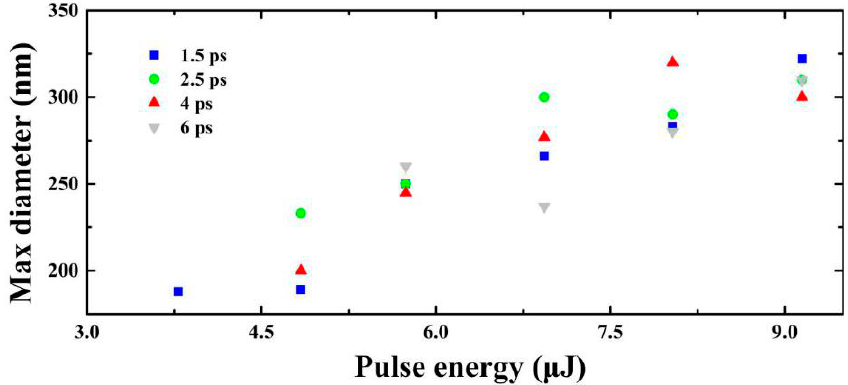
Figure 4. Maximum diameters of inside holes as a function of pulse energy measured inside the fused silica for different pulse widths.